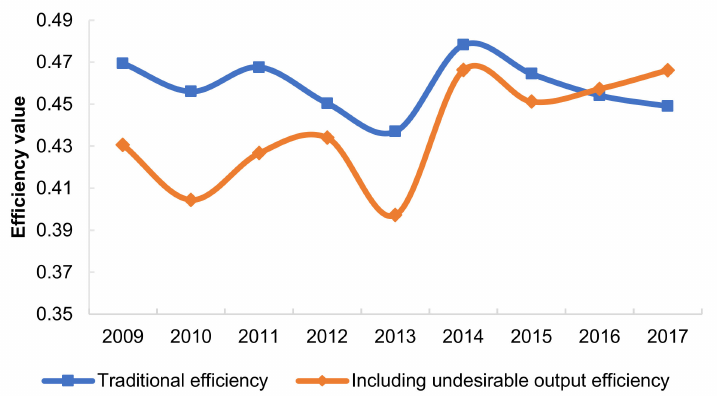
Figure 3. Average efficiency of construction land in the Yangtze River Delta from 2009 to